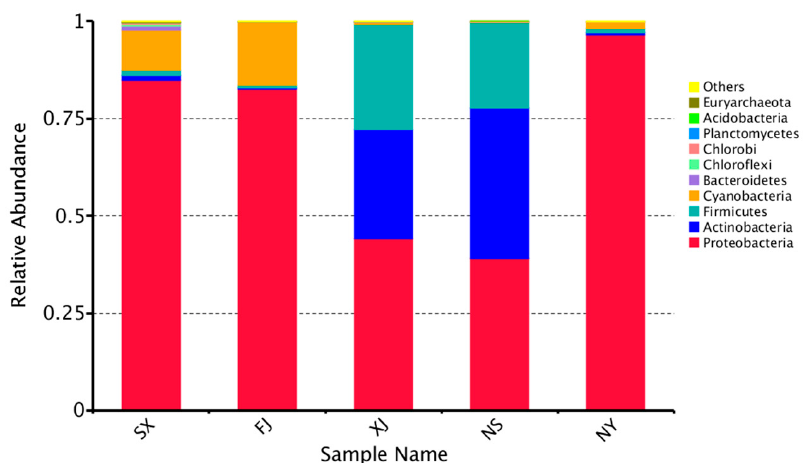
Figure 2. Relative abundance of the top 10 bacteria at the phylum level of taxonomy. The other phyla are included as “Others.”